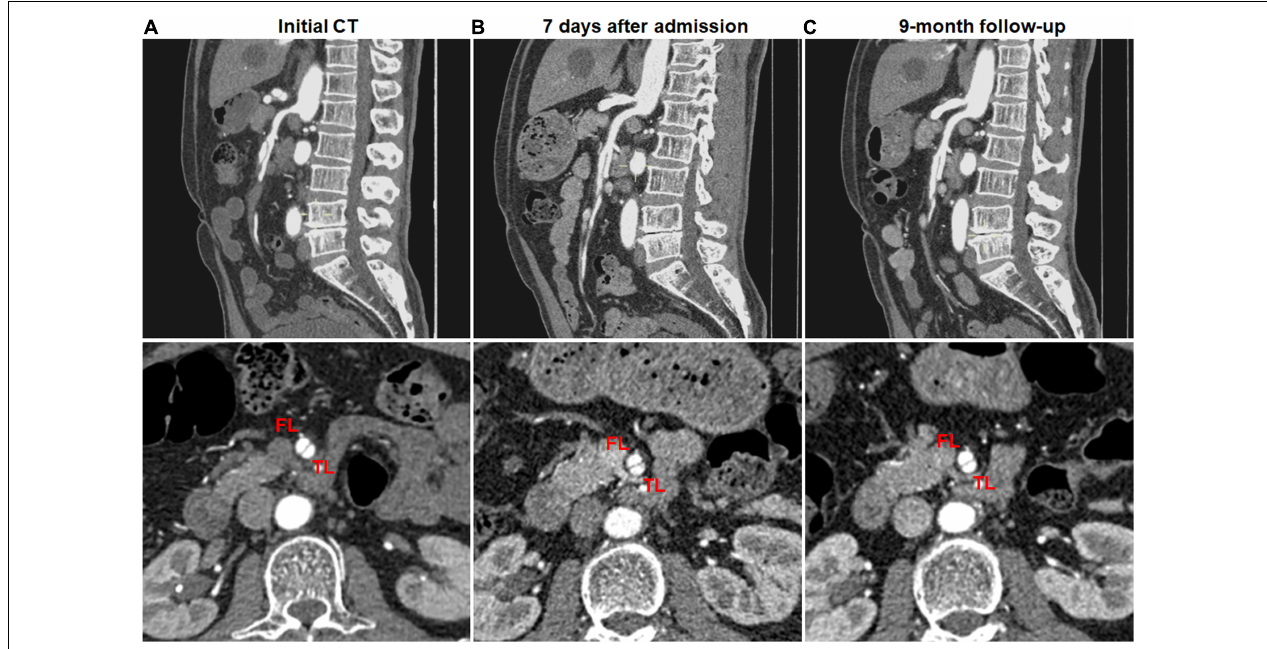
FIGURE 5 | No change of type I spontaneous isolated superior mesenteric artery dissection on follow-up computed tomography (CT) angiography. (A) Initial CT angiography showed patent false lumen and true lumen with both entry and re-entry in a 53-year-old man. (B) One week after conservative management, type I dissection showed no interval change. (C) Nine month later, patent false lumen was sustained with both entry and re-entry as well as no aneurysmal dilatation.